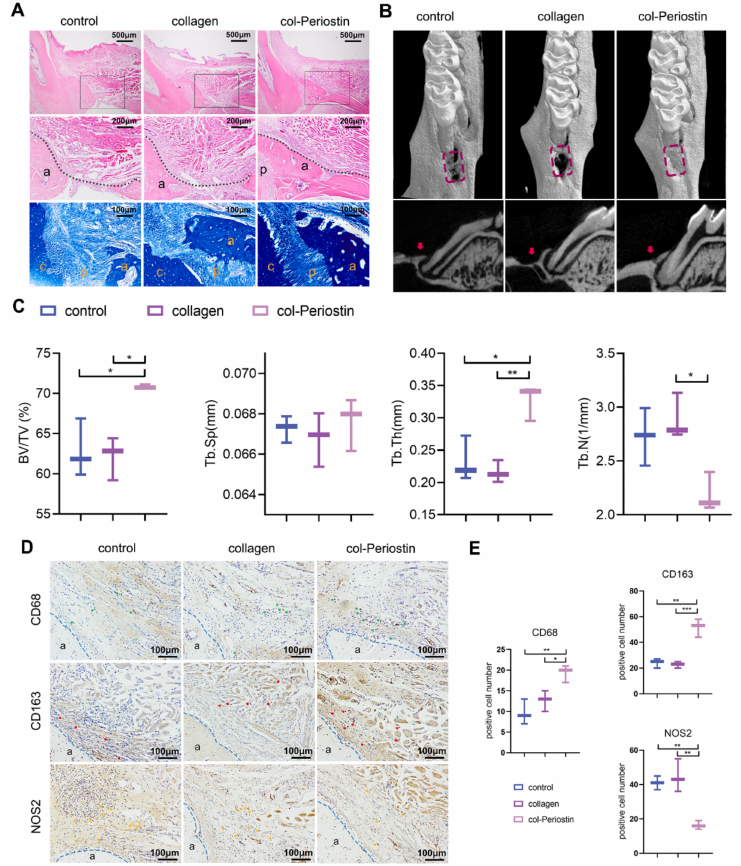
Figure 7. RhPeriostin promoted periodontal tissue regeneration. ( A ) HE and MT staining of peri- odontal regeneration at 4 weeks after periostin treatment. Images shown are representative